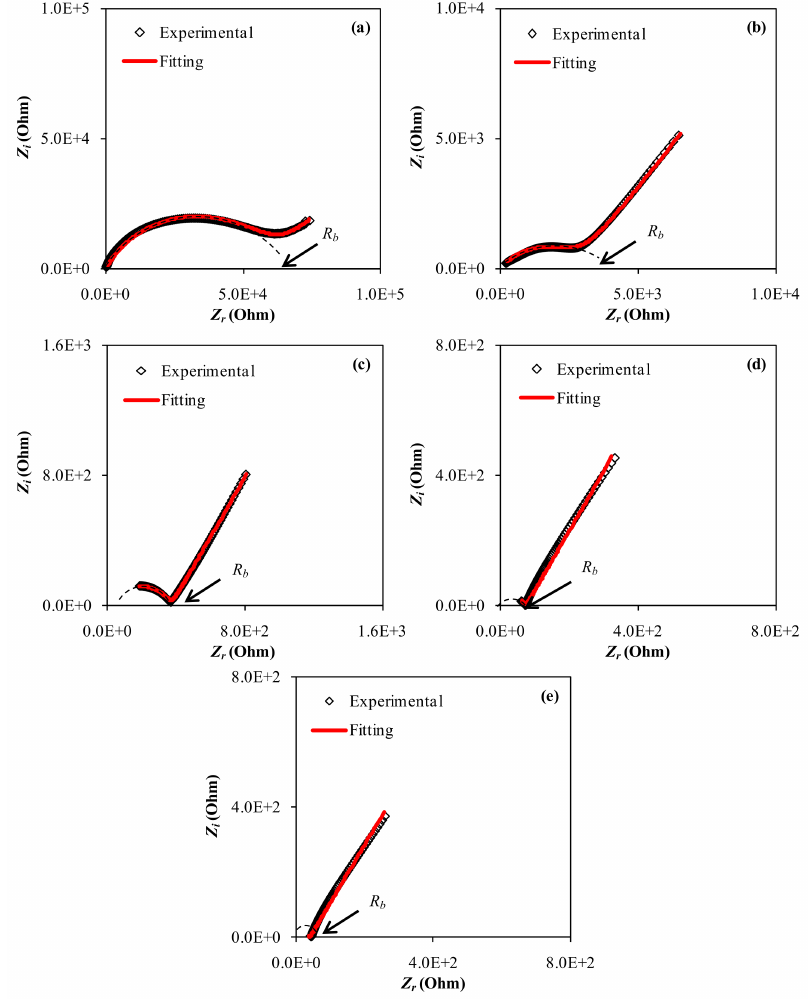
Figure 7. EIS plots for ( a ) CSPVNG11, ( b ) CSPVNG22, ( c ) CSPVNG33, ( d ) CSPVNG44 and ( e ) CSPVNG55 electrolyte